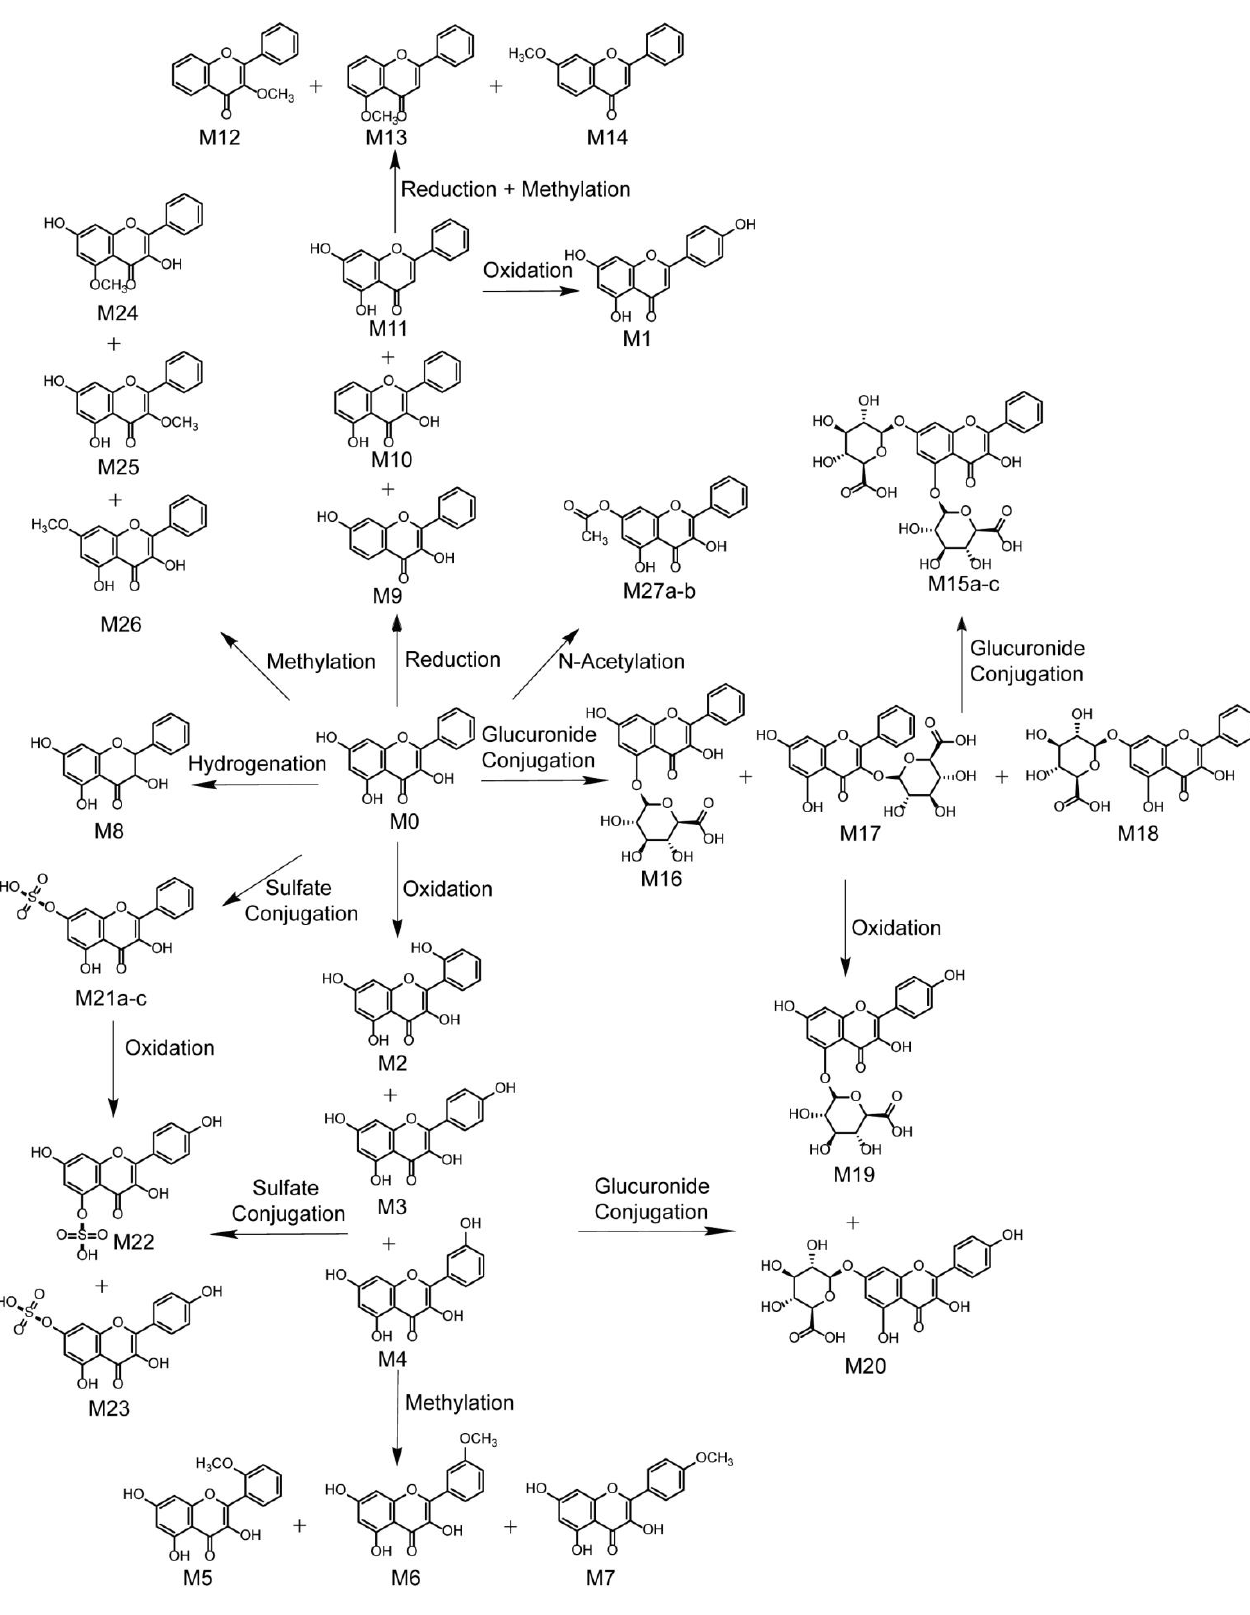
Figure 8. Metabolic profile and proposed metabolic pathways of galangin in vitro and in vivo (a, b, and c: possible chemical structure).